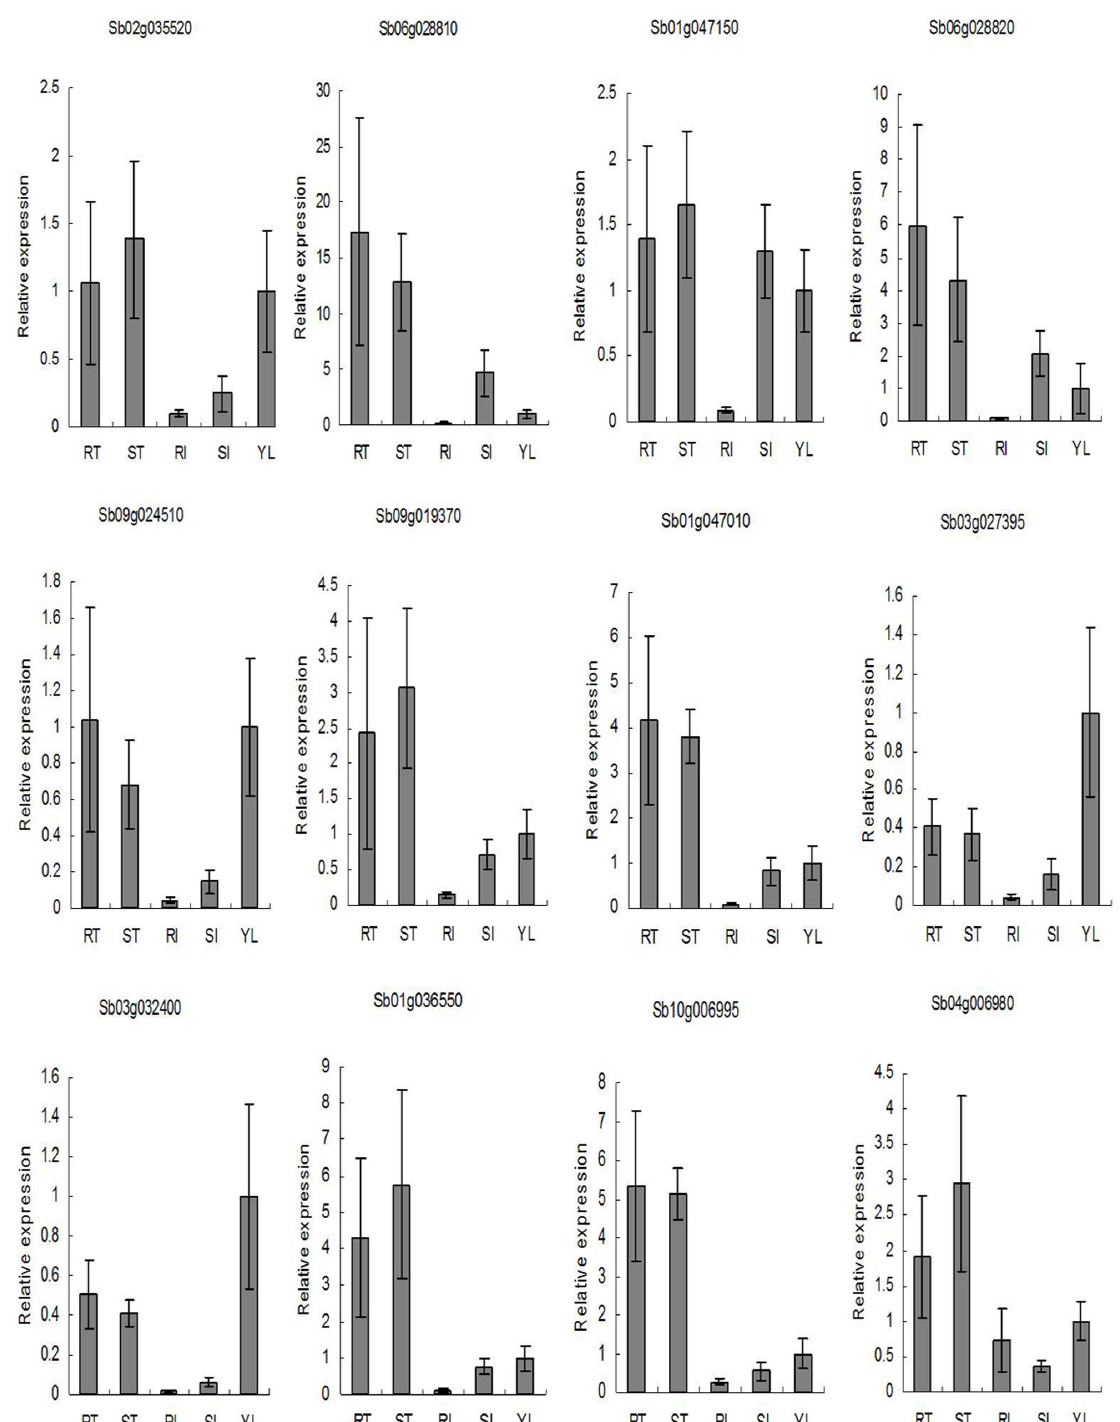
Figure 2. Real time PCR profiles of 12 selected tissue-enriched genes. RT, ST, RI, SI, and YL represent the rhizome tip, shoot tip, rhizome internodes, shoot internodes, and young leaves, respectively. Expression levels were calculated based on the expression level of YL genes set to 1. Expression profiles obtained by real time PCR for one gene, Sb01g036550, were not consistent with data obtained from microarray analysis. Correlation coefficients (r) for the remaining 11 genes were 0.74, 0.74, 0.74, 0.74, 0.77, 0.74, 0.82, 0.76, 0.76, 0.94, and 0.76, from left to right, respectively. Bars donate standard deviation.